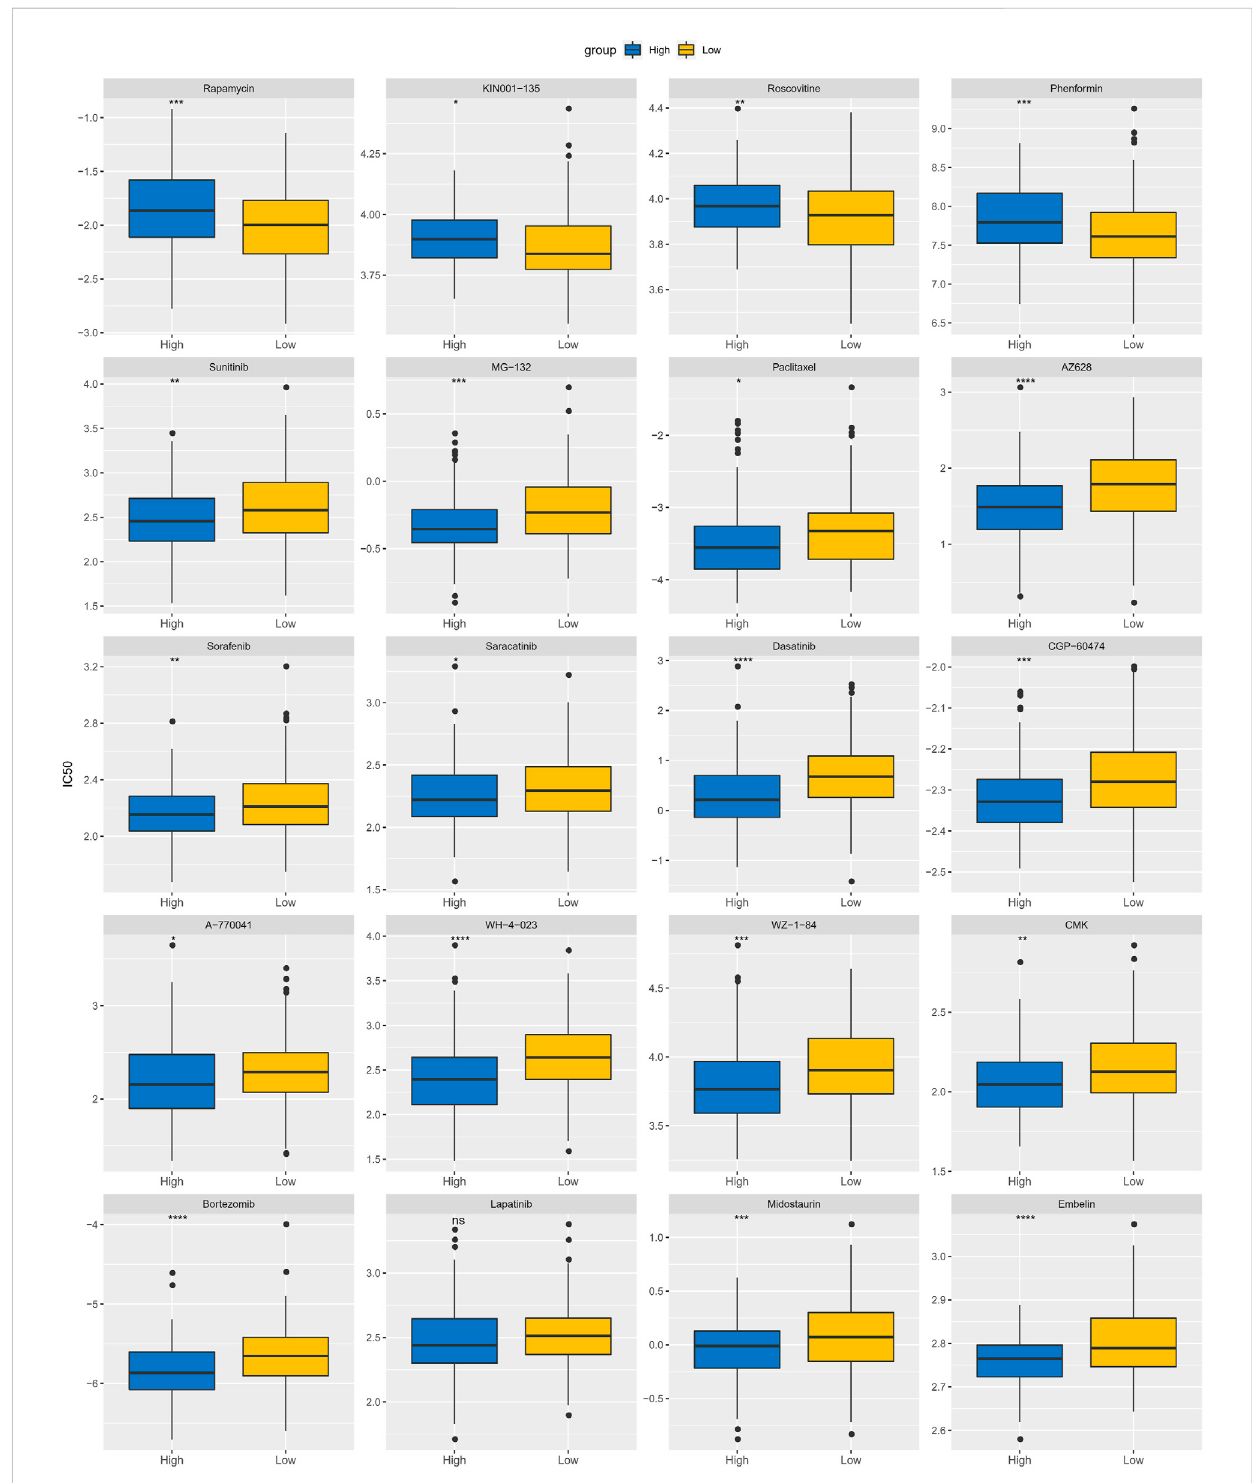
FIGURE 10 DifferencesofIC50 valuesfor 20chemotherapydrugs betweenAPR_ScoregroupsinTCGA-CESC cohort.ns p > 0.05;* p < 0.05;** p < 0.01;*** p < 0.001; **** p <